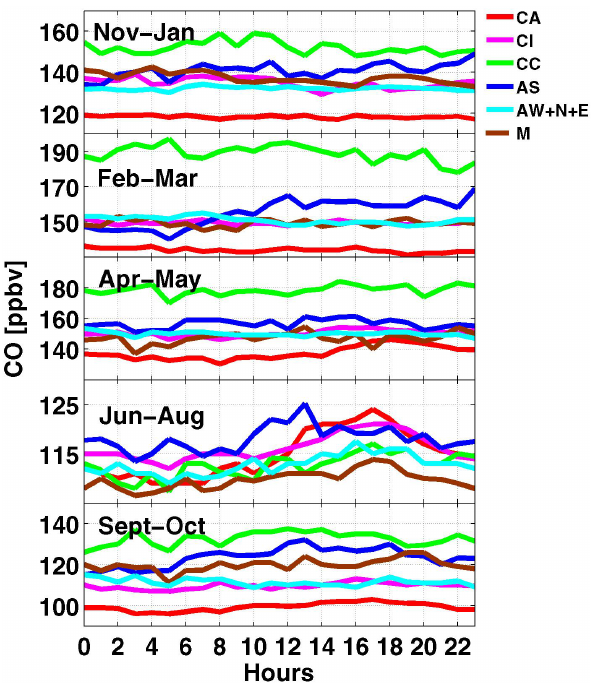
Fig. 9. Median 1995–2008 diurnal cycles of CO concentration for the 5 defined periods of the year as a function of SYNALP weather types.